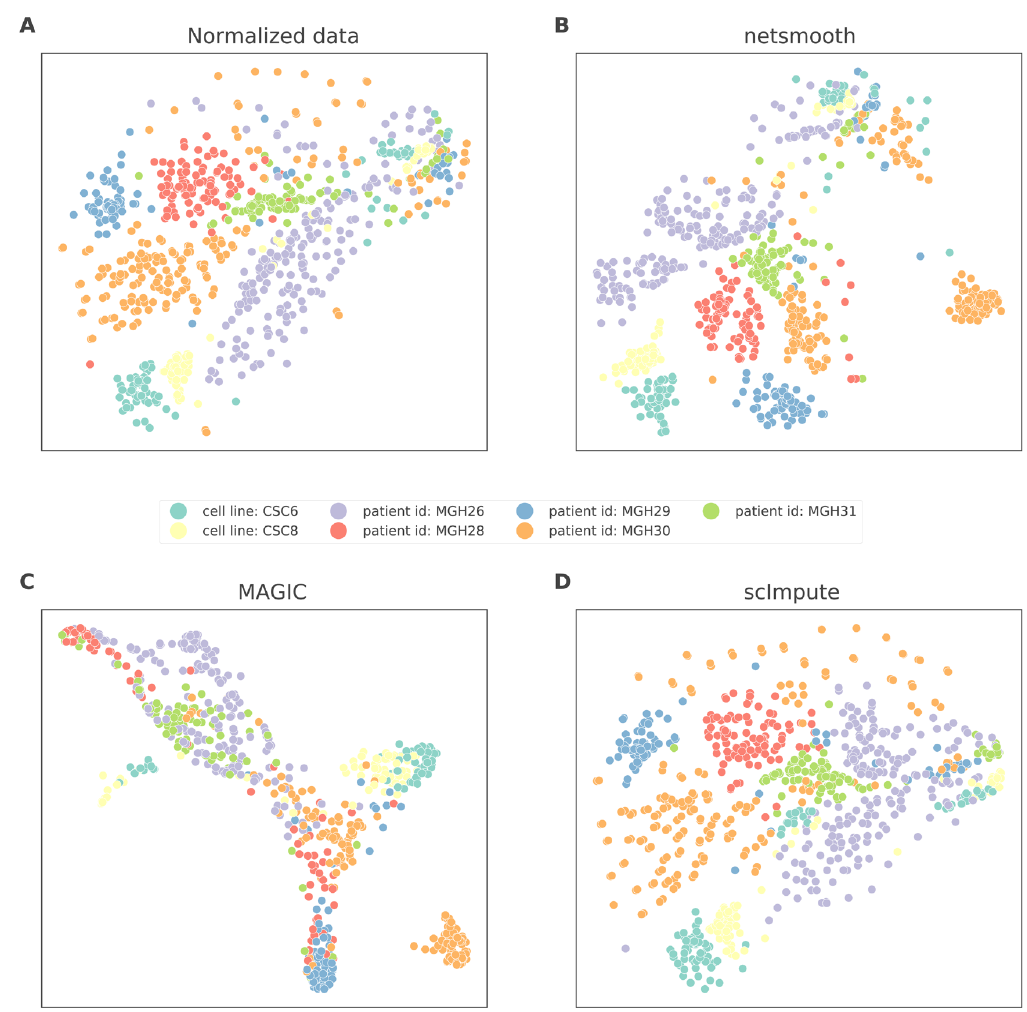
Figure 6. t-SNE plots of the glioblastoma dataset A ) no preprocessing, B ) after application of netSmooth , C ), using MAGIC, and D ) after application of scImpute. The online version of this figure is interactive.